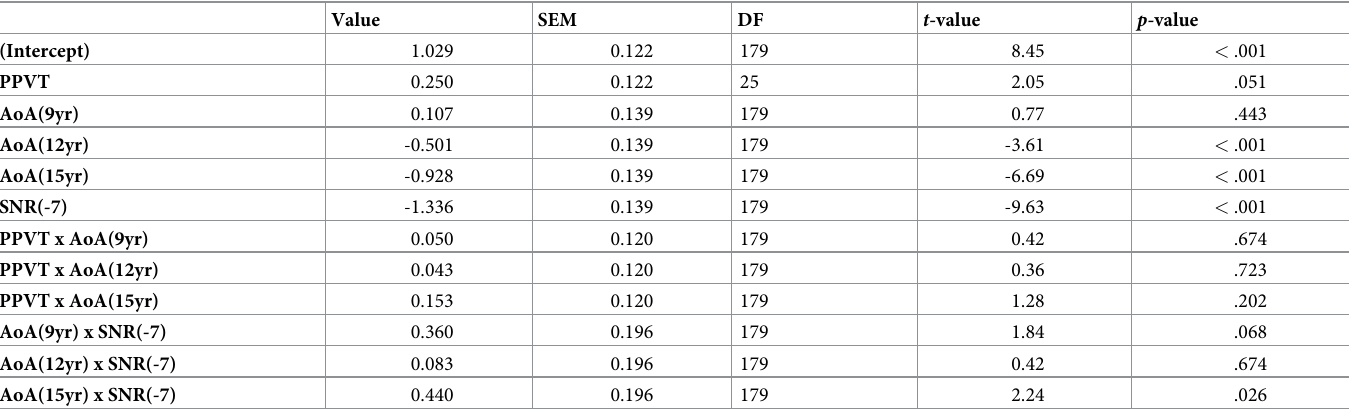
Table 1. Linear mixed model for results of Experiment